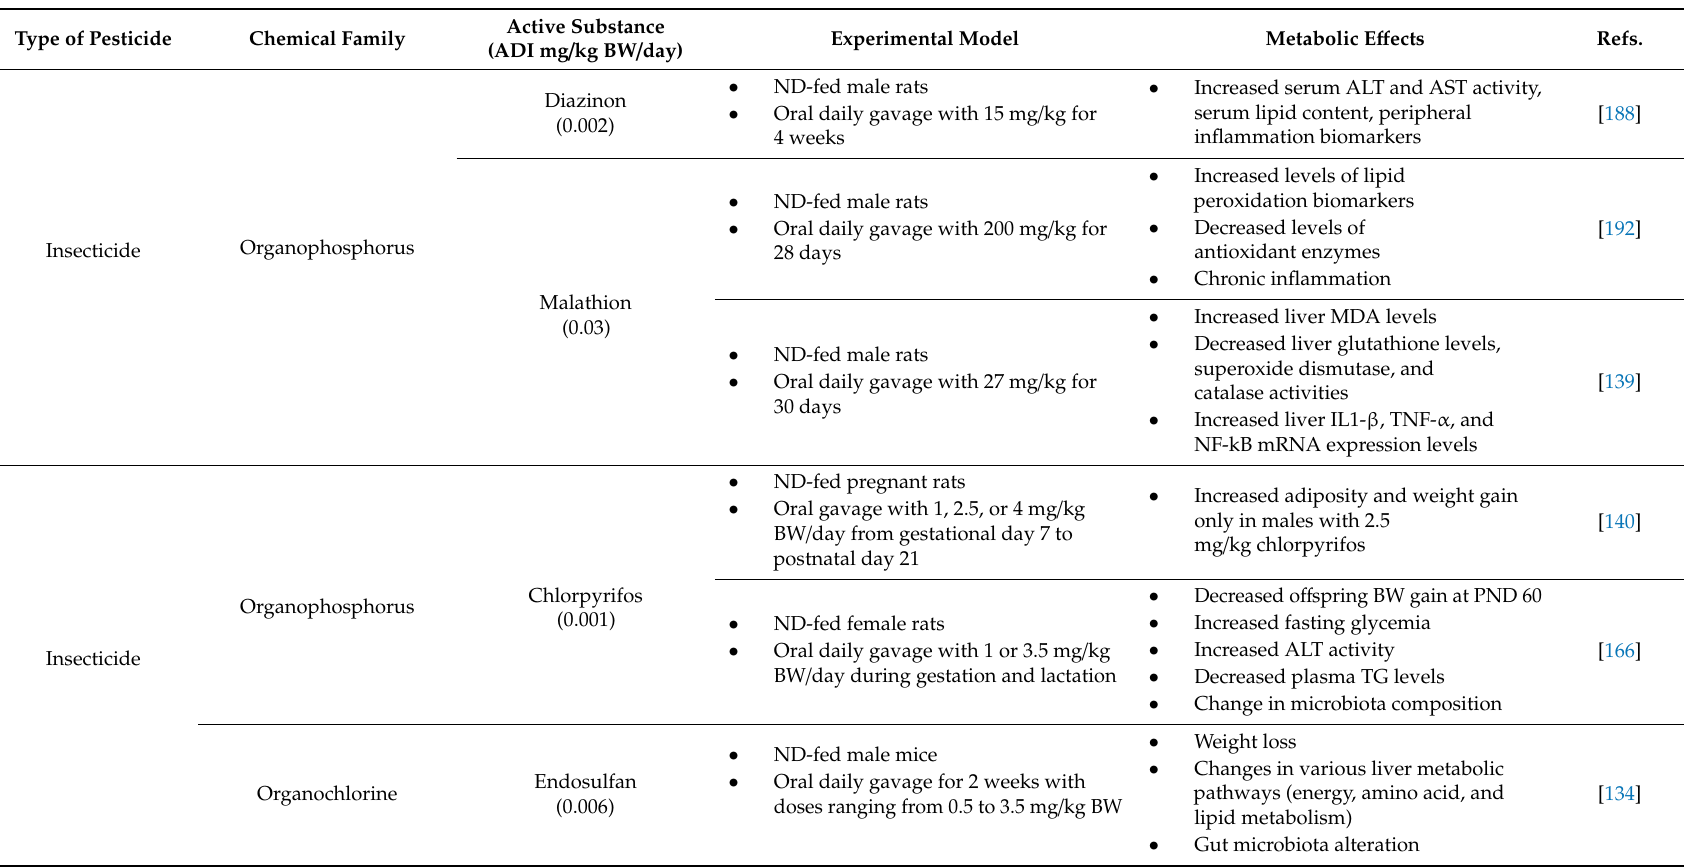
Table 1. Metabolic impact of pesticide exposure in normal diet-fed animal models. Acceptable Daily Intake (ADI) values were from https: // ephy.anses.fr / and https: // ec.europa.eu / food / plant / pesticides / eu-pesticides-database / . ADI, acceptable daily intake; ALT, alanine aminotransferase; AST, aspartate aminotransferase; BW, body weight; CAR, constitutive androstane receptor; GD, gestational day; HFD, high-fat diet; IL1- β , interleukin-1 beta LDH, lactate dehydrogenase; MDA, malonaldehyde; NOAEL, no observable adverse e ff ect level; ND, normal diet; NF-kB, nuclear factor kappa B, PND, postnatal day; SOD, Super oxide dismutase; TG, triglyceride, TNF- α , tumor necrosis factor alpha; ADI, Acceptable Daily